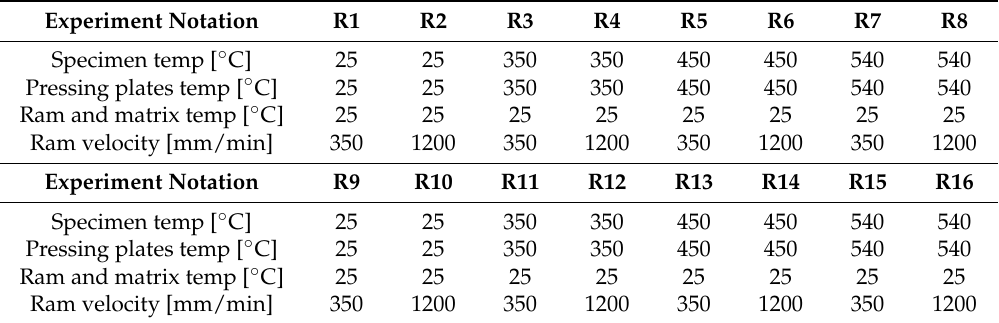
Table 2. Ring compression tests (RCTs) parameters: Initial temperatures, ram velocity, and lubrication